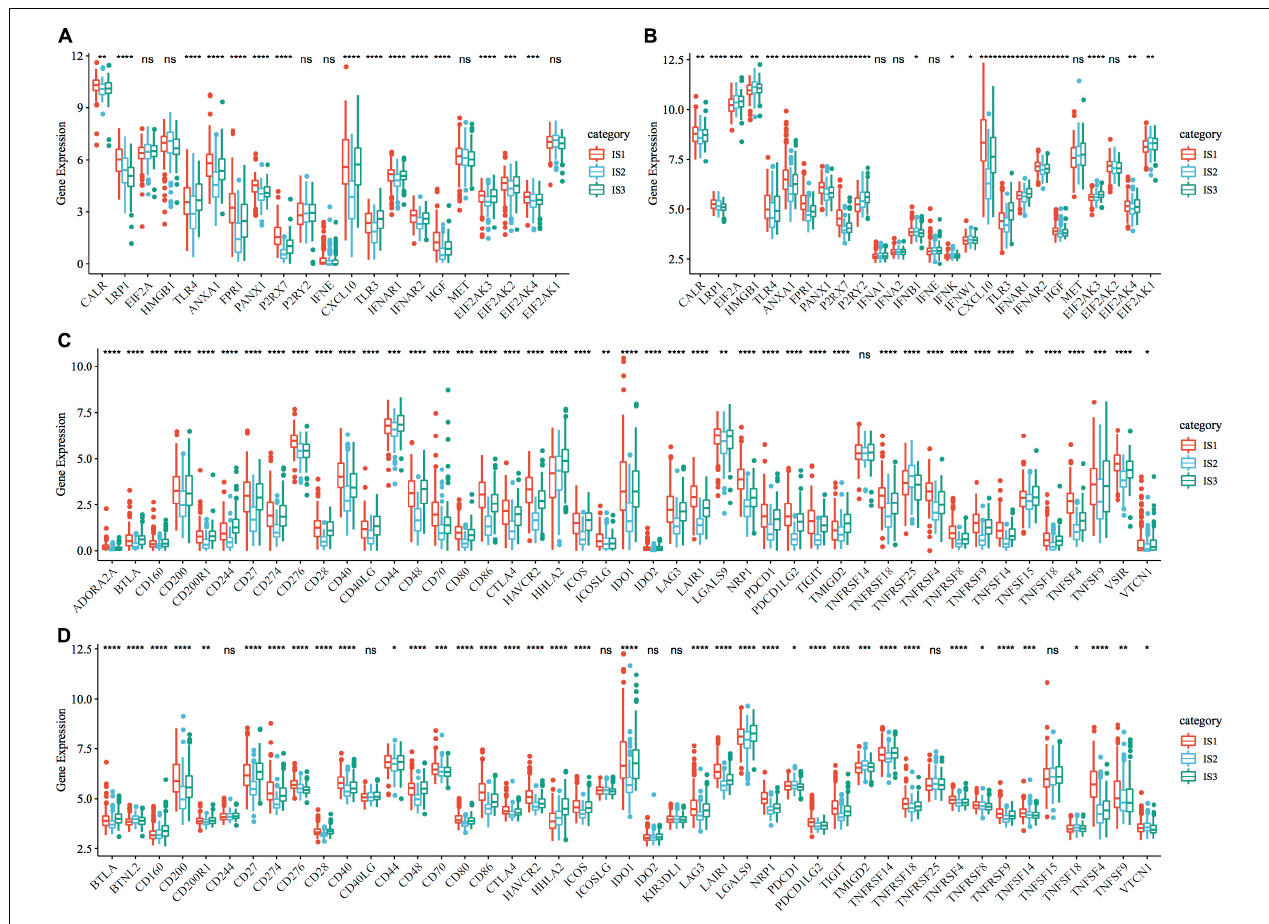
FIGURE 3 | Expression of chemotherapy-induced marker and immune checkpoint genes. (A) Differences in the expression and distribution of classical markers in chemotherapy-induced immune response in the TCGA-COAD cohort; (B) The expression and distribution of classical markers of chemotherapy-induced immune response were different among samples in the GSE39582 cohort; (C) Differences in the expression and distribution of immune checkpoint genes in the TCGA-COAD cohort; (D) The expression and distribution of immune checkpoint genes were different among samples in the GSE39582 cohort. The significance was statistically tested by one-way analysis of variance, * P < 0.05, ** P < 0.01, *** P < 0.001, **** P <